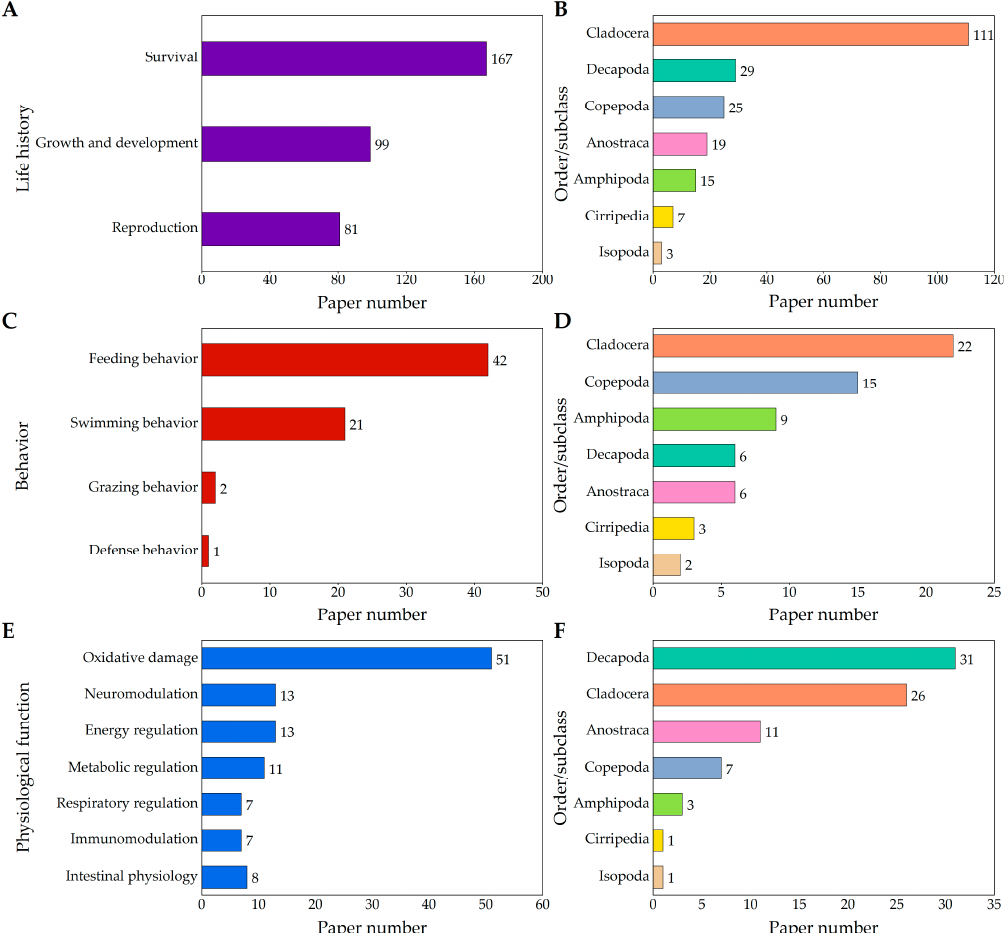
Figure 1. Effects of microplastics on aquatic crustaceans.